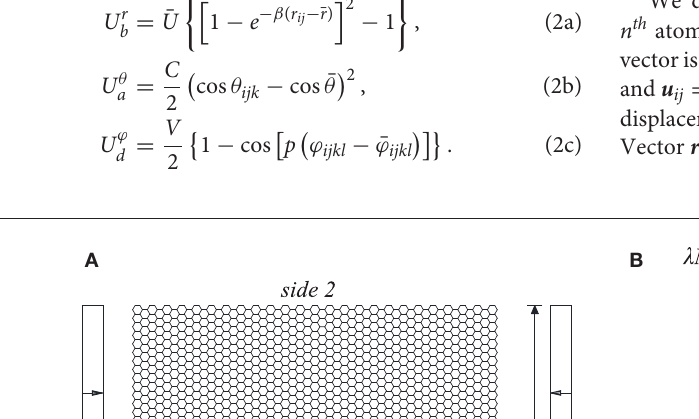
Frontiers in Materials |